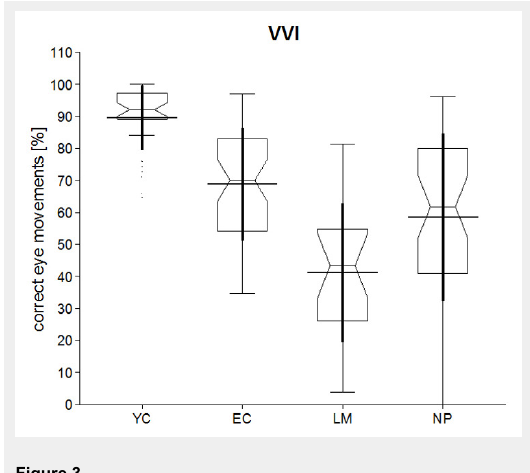
Evaluation of all visuovisual interactive (VVI) saccades for all groups. = young comparison